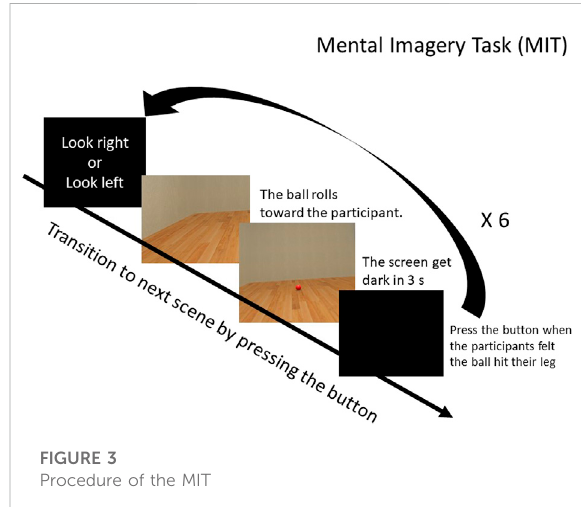
FIGURE 3 Procedure of the MIT